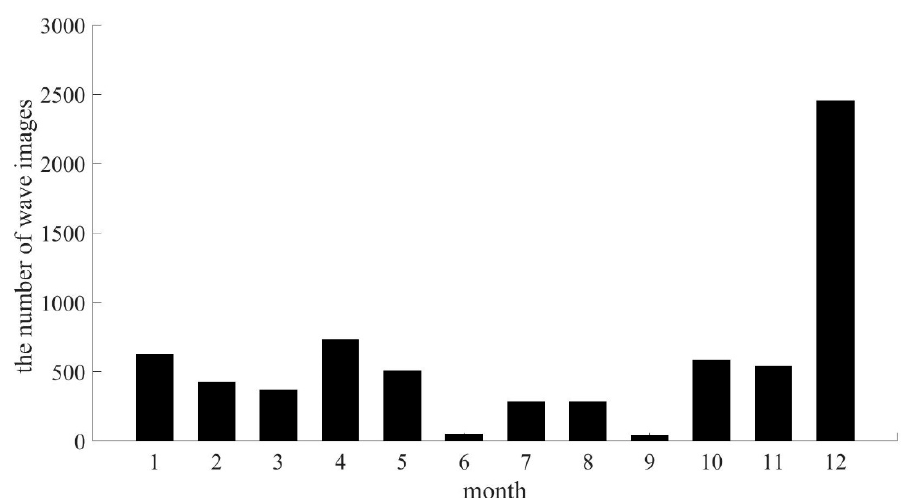
Figure 14. Monthly distributions of GW image numbers in 2014 at Linqu station. The all-sky airglow imager (ASAI) was out of work from 20 August to 20 September, which results in the abnormally low GW image numbers in September.